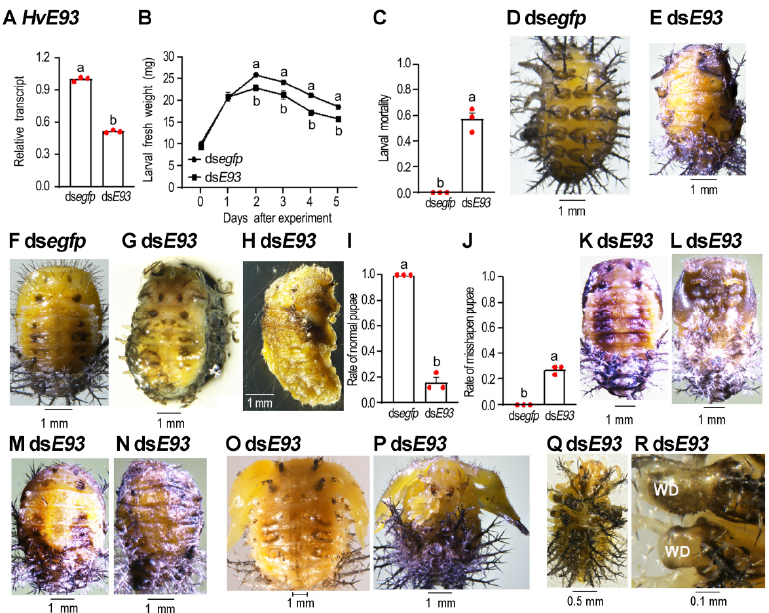
Figure 4. Depletion of both HvE93 isoforms in the final instar larvae arrests the development of Henosepilachna vigintioctopunctata larvae. Around 500 ng of ds E93 or ds egfp (0.1 µ L) was injected into the newly molted fourth-instar larvae. The ladybirds were subsequently confined in petri dishes containing potato foliage. Three days after injection, the expression level (2 − ∆∆ CT values) of HvE93 was measured ( A ). The resultant larvae were weighed 1 through 5 days after treatment ( B ). The larval mortality ( C ), rate of normal pupae ( I ) and rate of misshapen pupae ( J ) were recorded during a 3-week trial period. Different letters above the data (means ± SE) show a significant difference at p < 0.05 using an independent sample t -test. The resultant larvae arrest development at the prepupal stage ( E vs. D ). After removal of the larval exuviae, the dorsal ( G ) and lateral ( H ) views of the resultant prepupae are shown, compared with the control pupa ( F ). The defective phenotypes of the treated pupae are shown ( M – Q ), compared with the control ( F ). The thorax of the treated pupae in ( Q ) are amplified ( R ) to show stretched fore- and hindwing discs